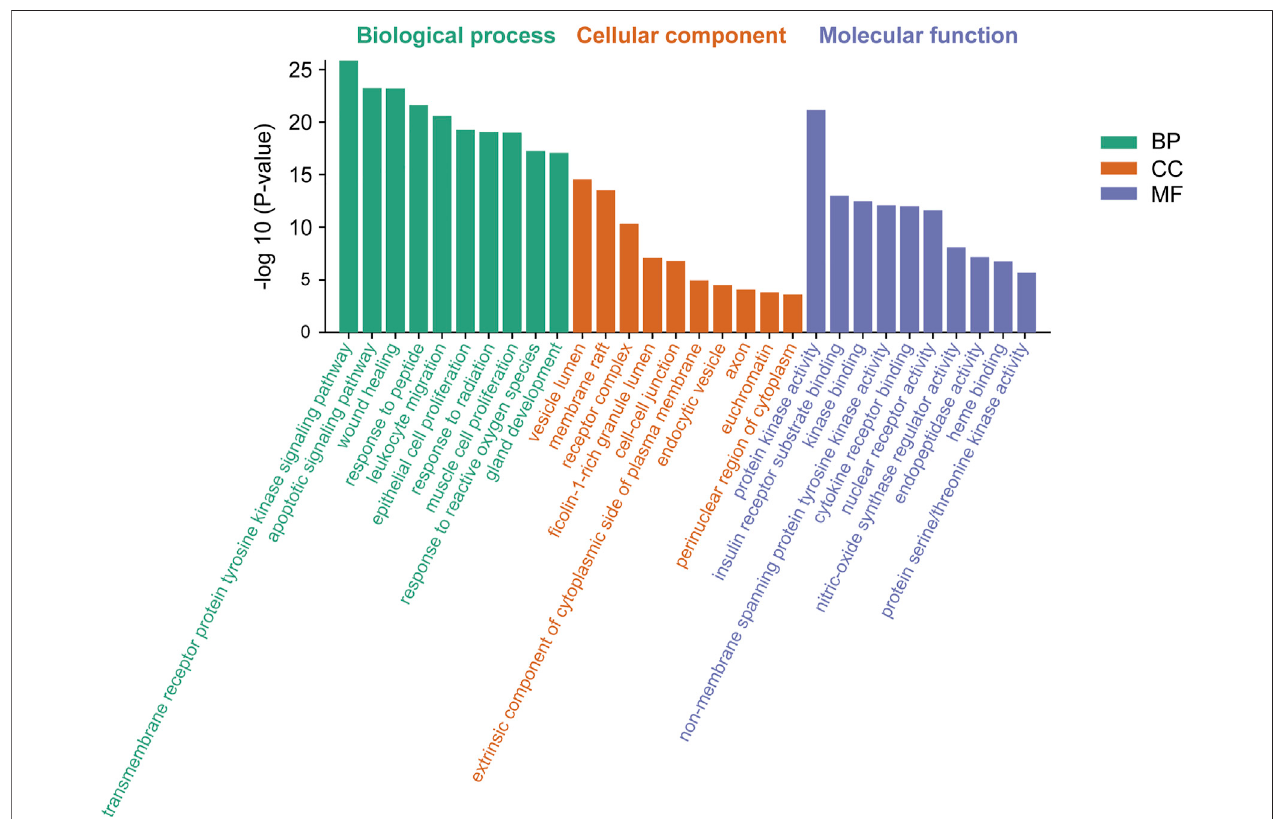
FIGURE 5 | Gene Ontology (GO) enrichment analysis of genes encoding the intersection targets. The terms in green represent biological processes, the terms in orange represent cellular components, and the terms in purple represent molecular functions.